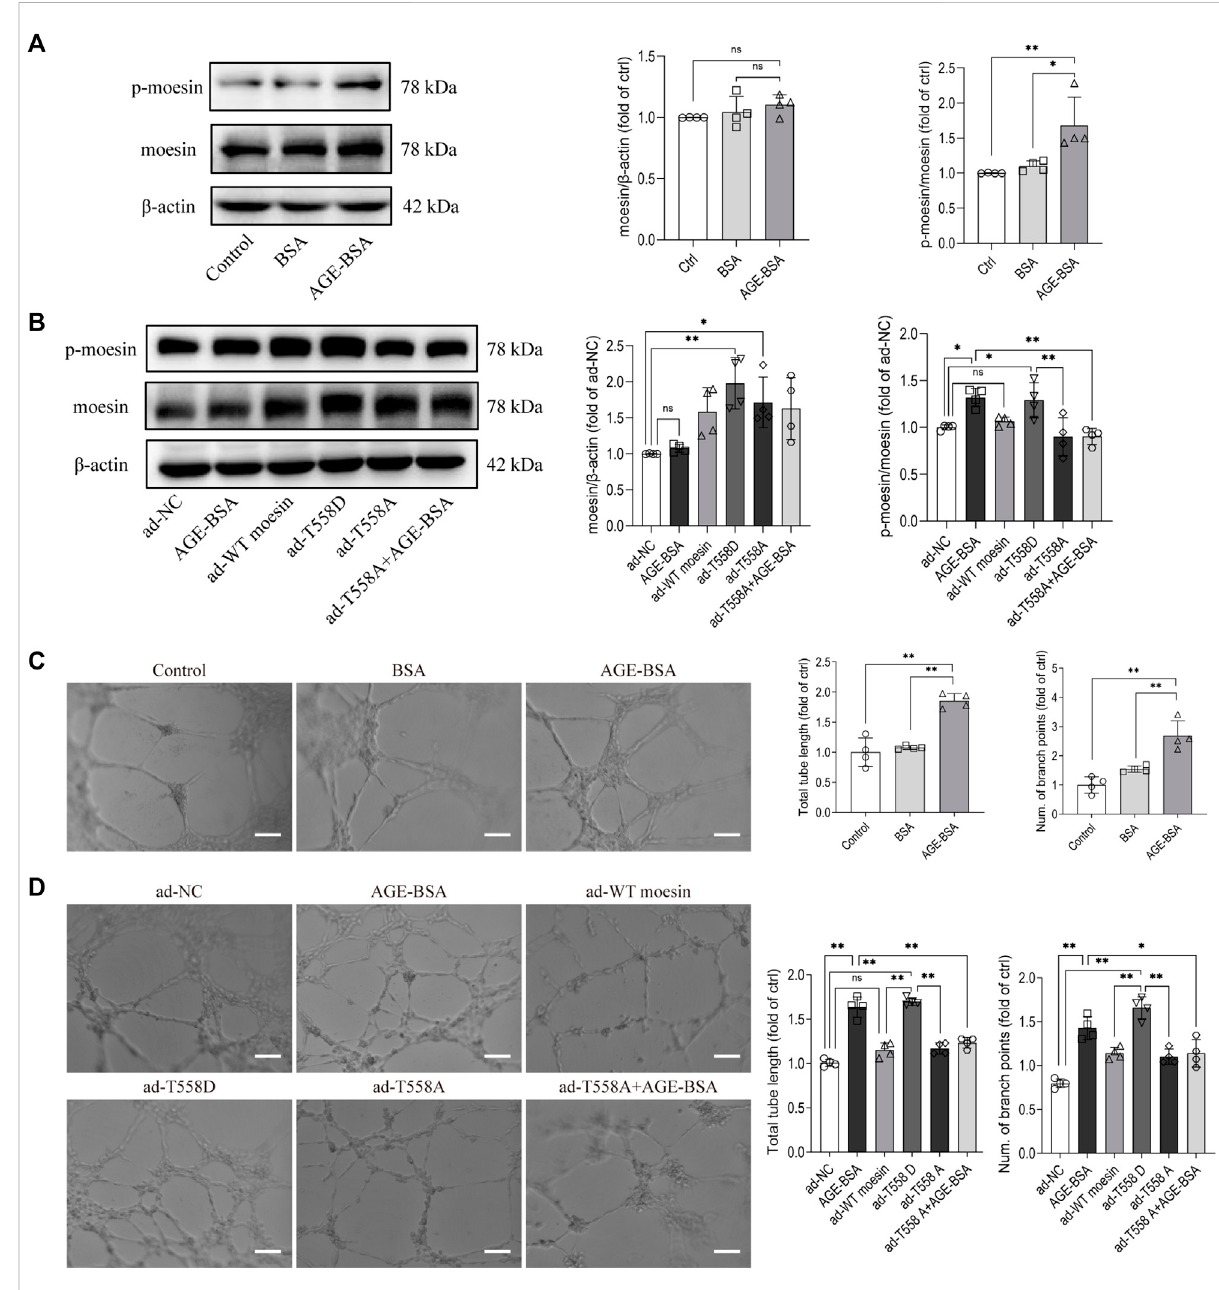
FIGURE 9 Moesin T558 phosphorylation is important in the AGE-mediated tube formation of GECs. The state of moesin phosphorylation in GECs after AGE-BSA (A) and moesin mutant adenovirus (B) treatments were detected. Tube formation of GECs treated with AGE-BSA (C) or wild-type moesin (ad-WT moesin), moesin T558D (ad-T558D), and moesin T558A (ad-T558A) adenovirus (D) is shown. Scale bar = 20 μ m. n = 4, * p < 0.05, and ** p <